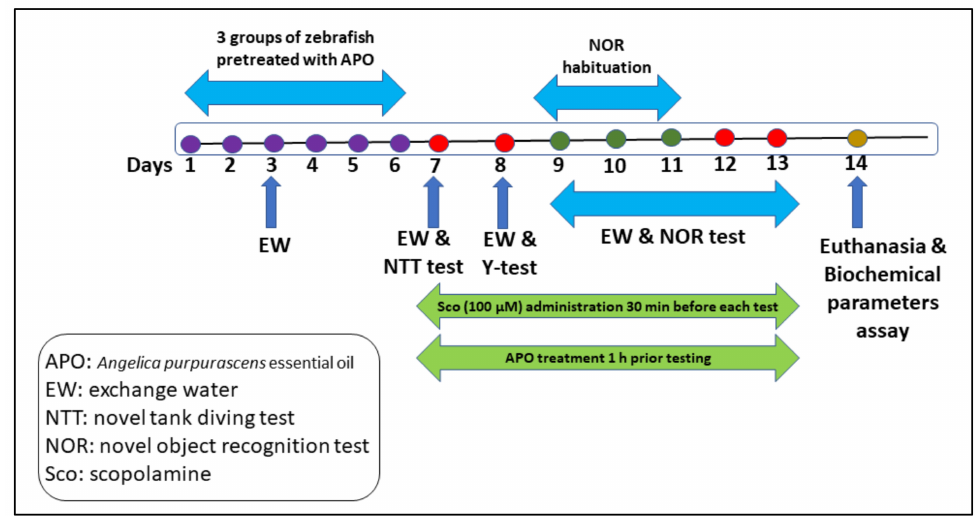
Figure 6. The experimental design of the